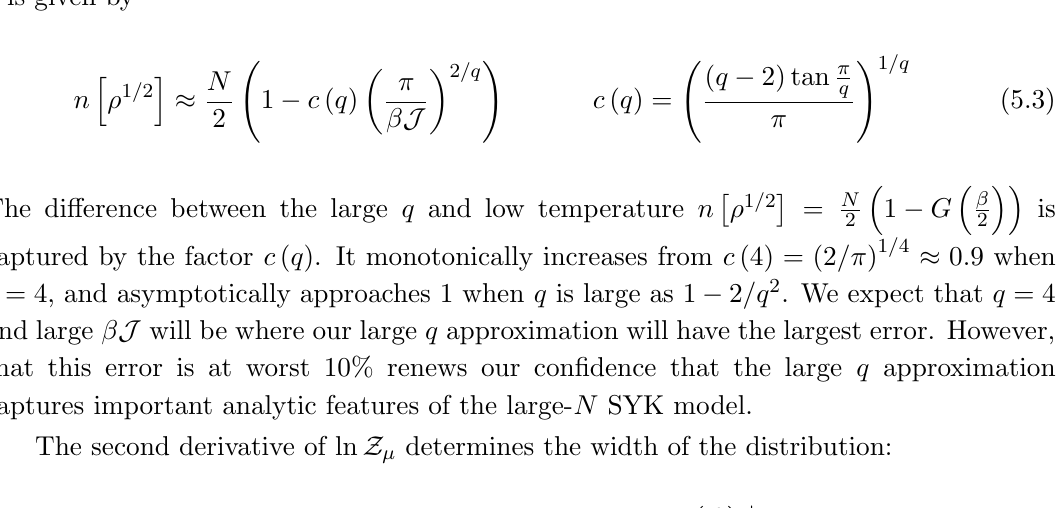
expression for the two-point function implies that the average size of (cid:26) 1 = 2 when N (cid:29) (cid:12) J (cid:29) 1 is given